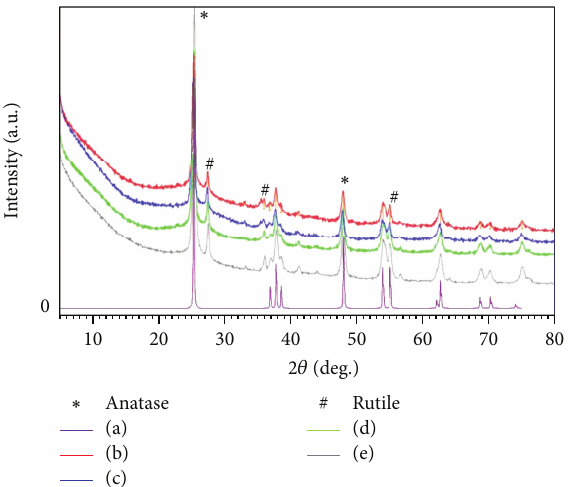
Figure 2: XRD patterns of (a) 1wt% Ppy/TiO 2 , (b) 2wt% Ppy/TiO 2 , (c) 3wt% Ppy/TiO 2 , (d) 4 wt% Ppy/TiO 2 , and (e) 5 wt% Ppy/TiO 2 composites.